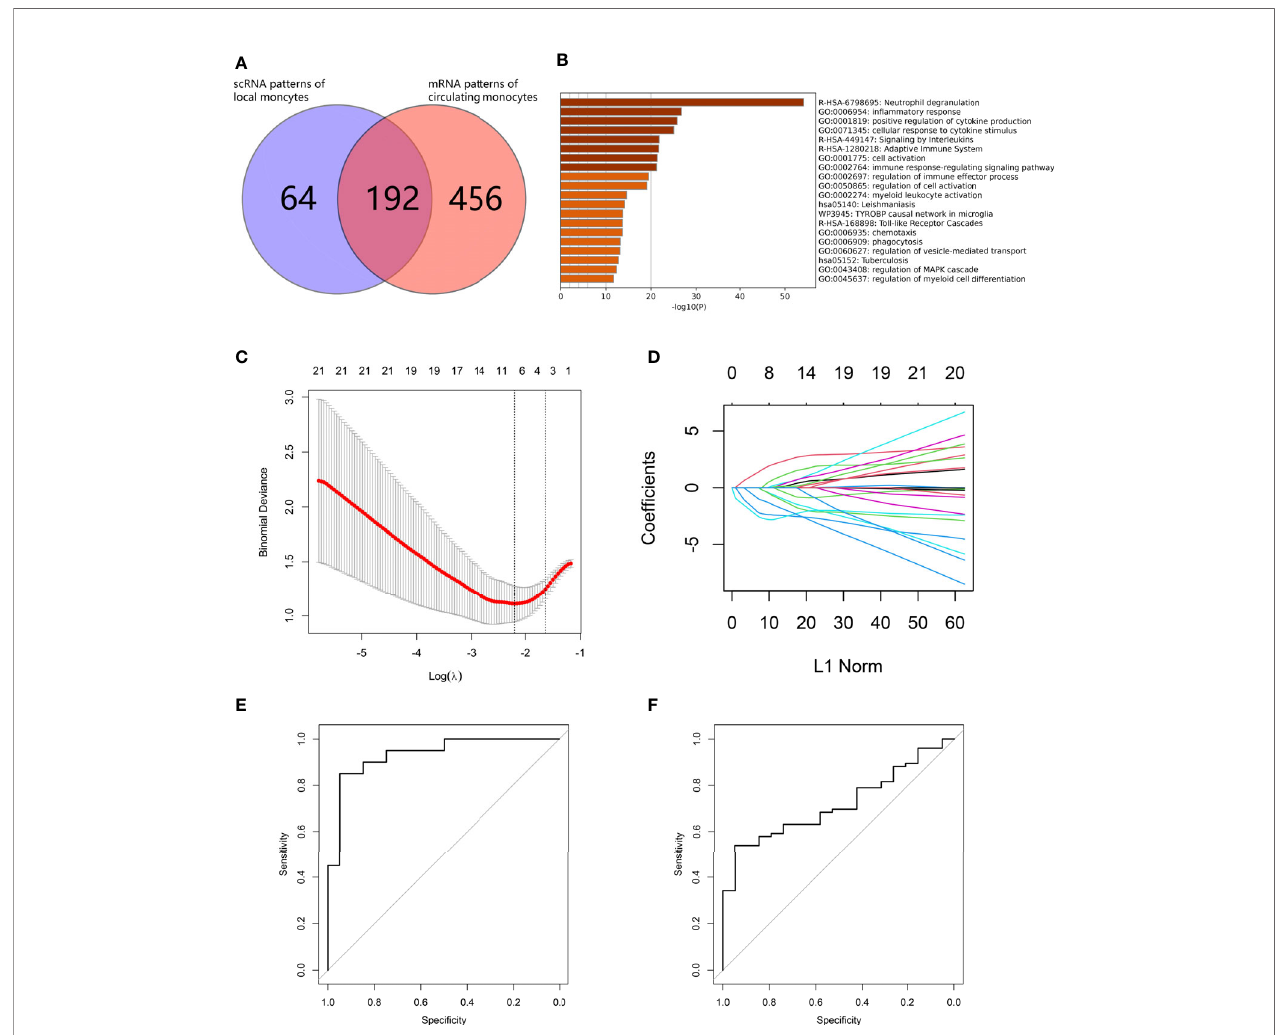
FIGURE 9 | Development of a calci fi cation paradox risk scoring model. (A) Venn diagram showing common genes between scRNA-based markers of CD14 + monocytes and mRNA-based markers of circulating CD14 + monocytes in both diseases. (B) Bar plot for the top-ranked gene set enrichment in common genes between scRNA-based markers of CD14 + monocytes and mRNA-based markers of circulating CD14 + monocytes in both diseases. (C – F). establishment of the Calci fi cation Paradox Risk Scoring Model on circulating CD14 + monocytes in both diseases. (C) Calculation paradox expression features on circulating CD14 + monocyte selection in the LASSO model. (D) Coef fi cient curves of the calci fi cation-related gene curves. (E) ROC curves to assess the accuracy of the Calci fi cation Paradox Risk Scoring Model on circulating CD14 + monocytes to predict osteoporosis in the training groups. (F) ROC curves to assess the accuracy of the